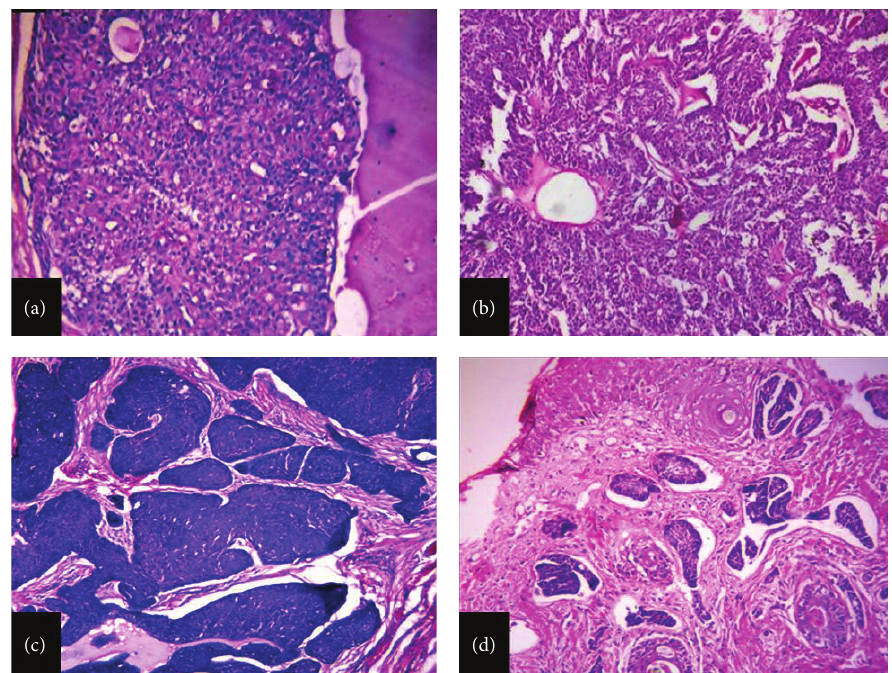
Figure 1: (a) Nodular hidradenoma, showing clear and polygonal cells with foci of eosinophilic material (H&E, × 100). (b) Hidradenoma papilliferum, showing scattered cystic and branching spaces with numerous papillary projections lined by double layer of epithelium (H&E, × 100). (c) Eccrine spiradenoma, showing well circumscribed aggregates of tumour cells in dermis (H&E, × 100). (d) Syringoma, showing numerous small ducts embedded in a fibrous stroma (H&E, × 100).